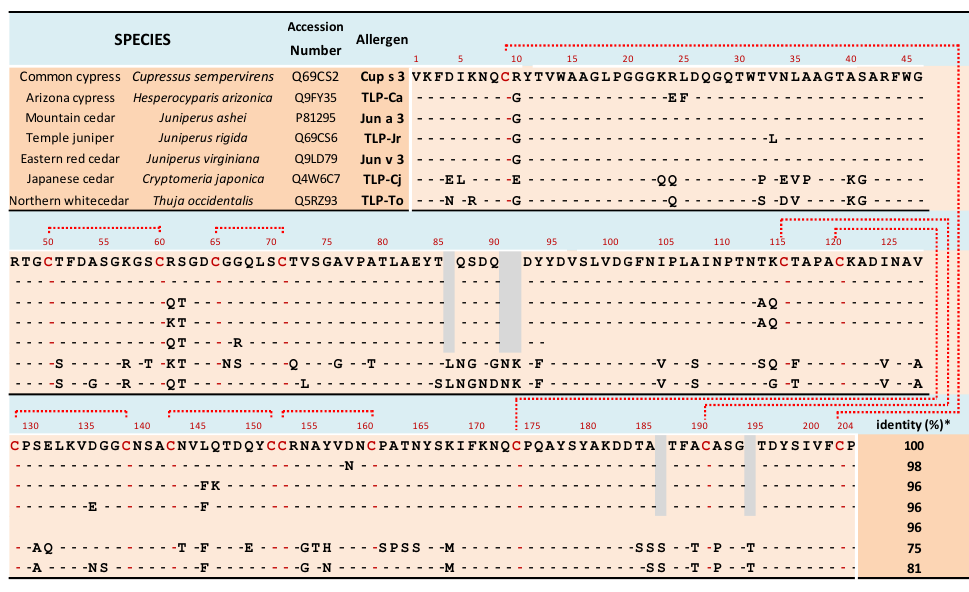
Table 2. Multiple amino-acid sequence alignments of seven thaumatin-like proteins from Cupres- saceae pollen. The sequence of Jun v 3 is incomplete in the NCBI databank. Grey boxes correspond to the absence of insertion which are only present in TLP-Cj and TLP-To. Cystein residues are in red and red dotted lines indicate the eight disulfide bridges.